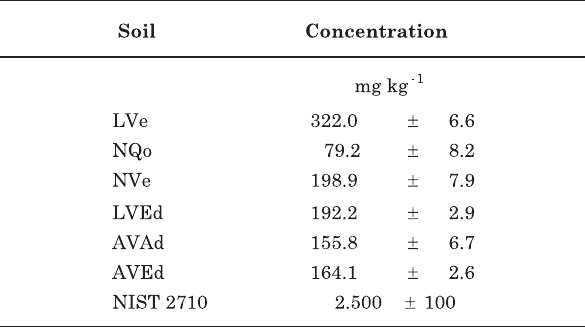
Table 3. Total S of soils by nitric digestion in a closed system (n = 4)